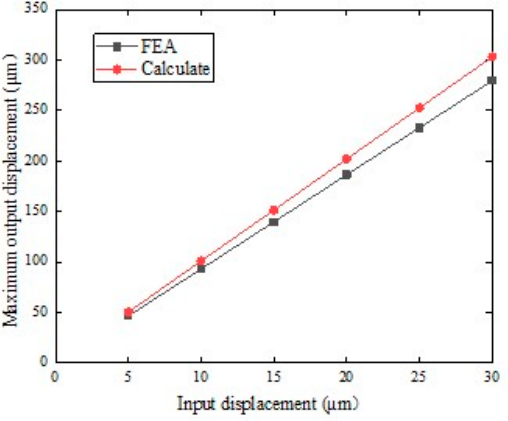
Figure 6. Relationship input displacement and maximum output displacement.